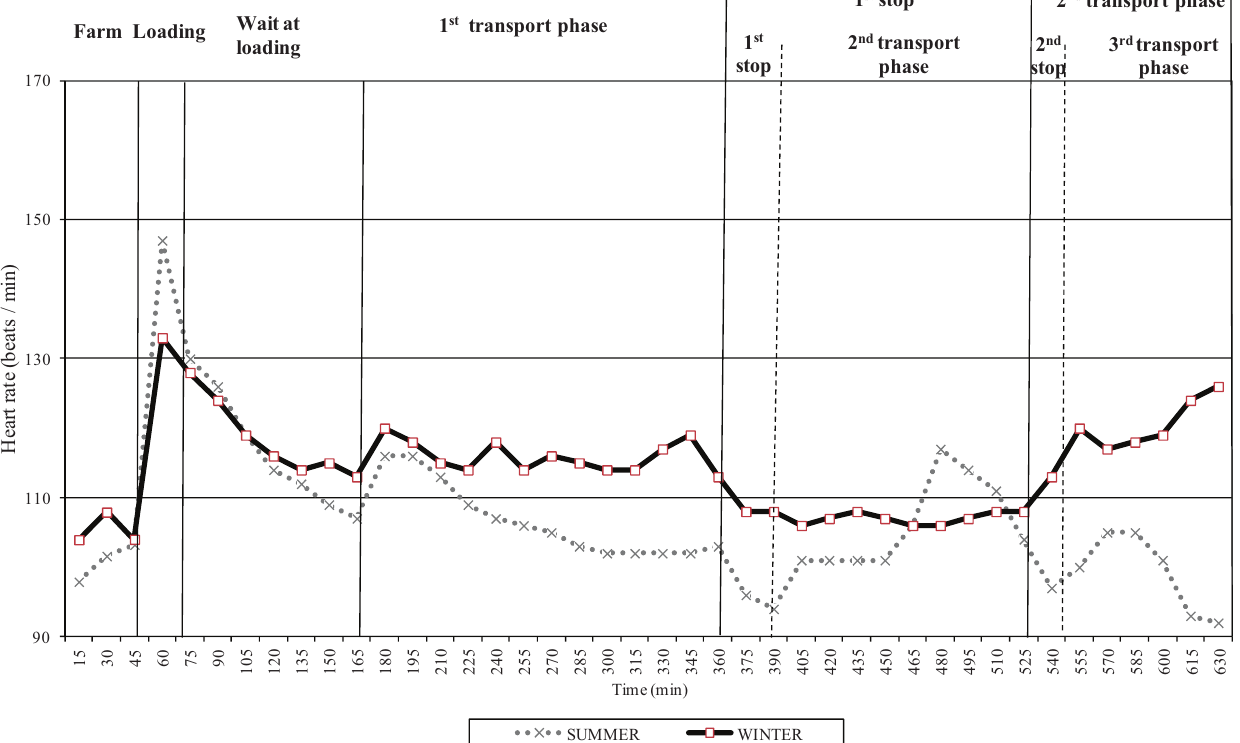
Figure 2. Heart rate from loading at the farm to 8 h transit time of pigs transported in a pot belly trailer in summer (six journeys) and winter (five